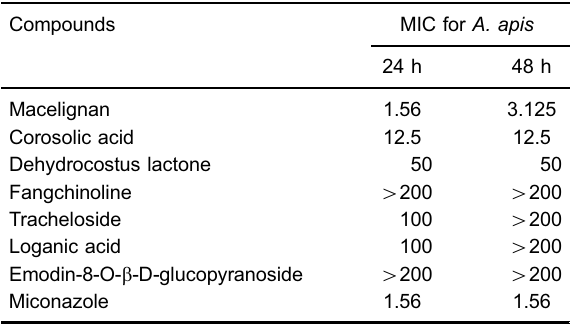
Table 1 . In vitro antifungal activity of various compounds against A. apis at 24 and 48 h. Compounds